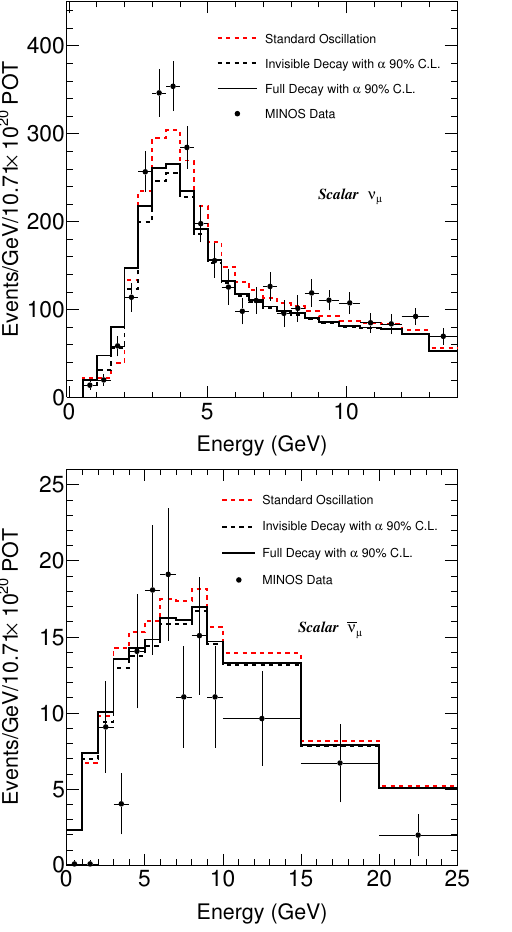
= 2 : 41 (cid:2) 10 (cid:0) 3 eV 2 , s 2 = 0 : 41, s 2 = 32 23 13